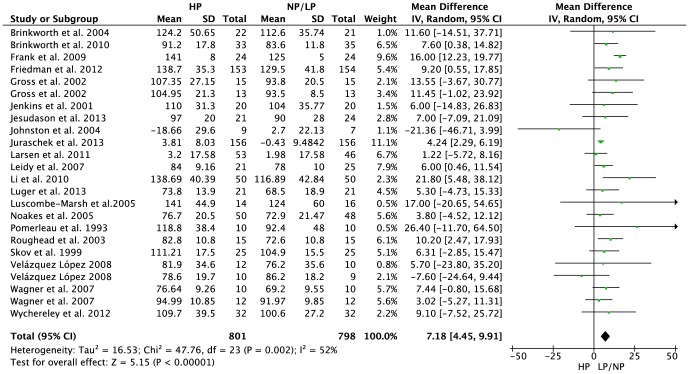
Forest plot showing pooled MD with 95% CI for glomerular filtration rate (ml/min/1.73 m2) of 21 randomized controlled HP diet trails.For each high protein study, the shaded square represents the point estimate of the intervention effect. The horizontal line joins the lower and upper limits of the 95% CI of these effects. The area of the shaded square reflects the relative weight of the study in the respective meta-analysis. The diamond at the bottom of the graph represents the pooled MD with the 95% CI. HP, high protein; NP/LP, normal protein/low protein.